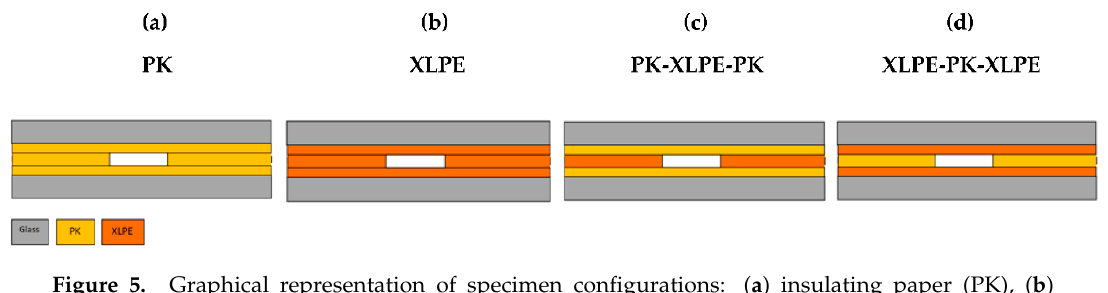
Figure 6. Measuring set-up for PD acquisition at AC and DC voltage: R 1 , R 2 —resistive divider, C k —coupling capacitor, Z m —coupling impedance, SCU—signal conditioning unit and preamplifier.